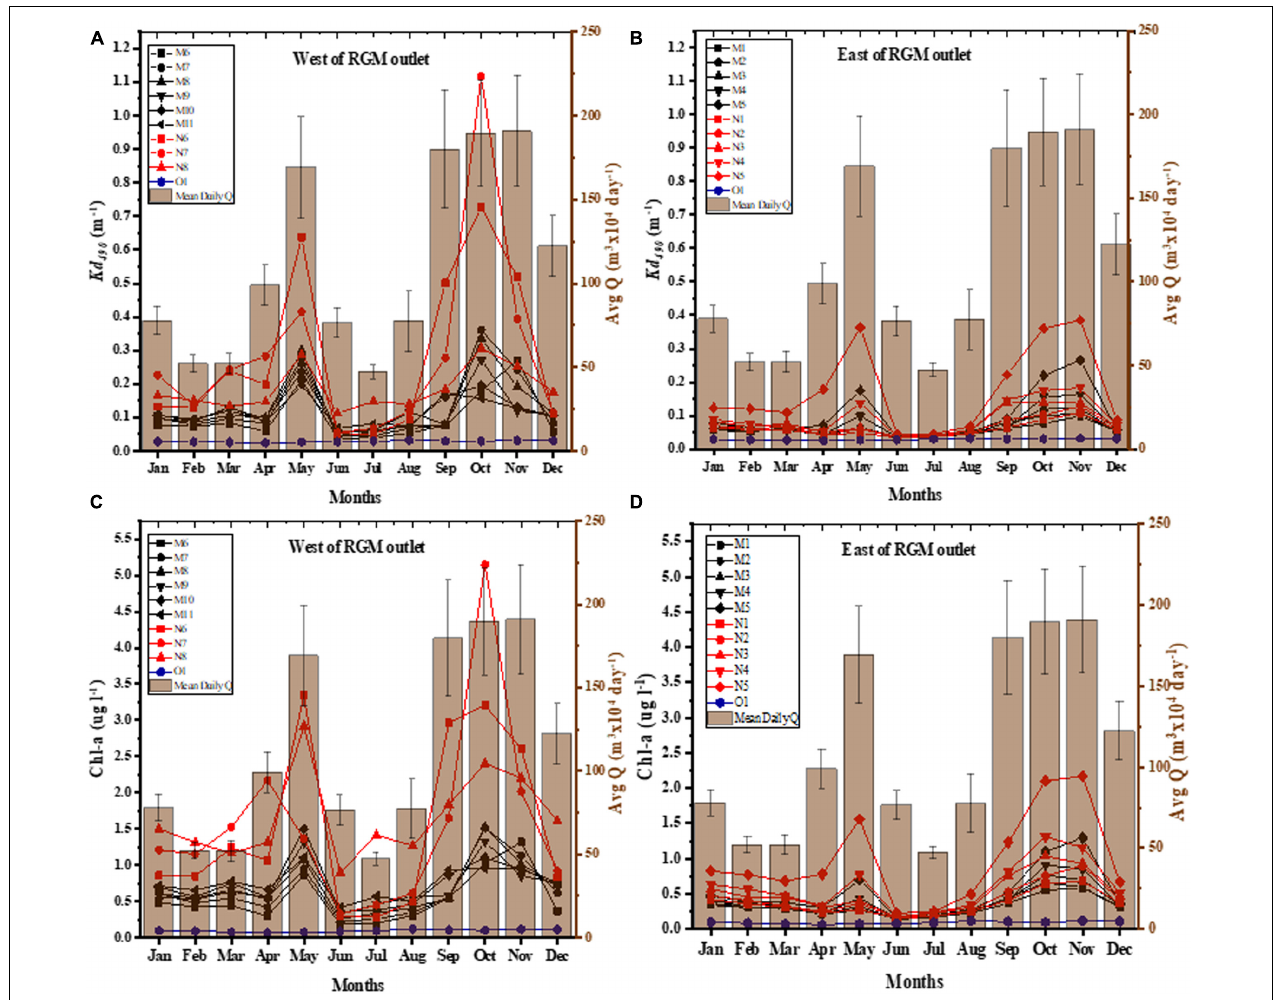
FIGURE 4 | VIIRS time-series analysis (nearshore stations) from 2012 to 2019 of Kd 490 and Chl-a compared to monthly mean of Q (from the USGS RGM streamflow station) for each month of the year. (A) Kd 490 for virtual stations north-west of the river outlet (nearshore: N6–N8; mid-platform: M6–M11). (B) Kd 490 for virtual stations east of the river outlet (nearshore: N1–N5; mid-platform: M1–M5). (C) Chl-a for virtual stations north-west of the river outlet (nearshore: N6–N8; mid-platform: M6–M11). (D) Chl-a for virtual stations east of the river outlet (nearshore: N1–N5; mid-platform: M1–M5).